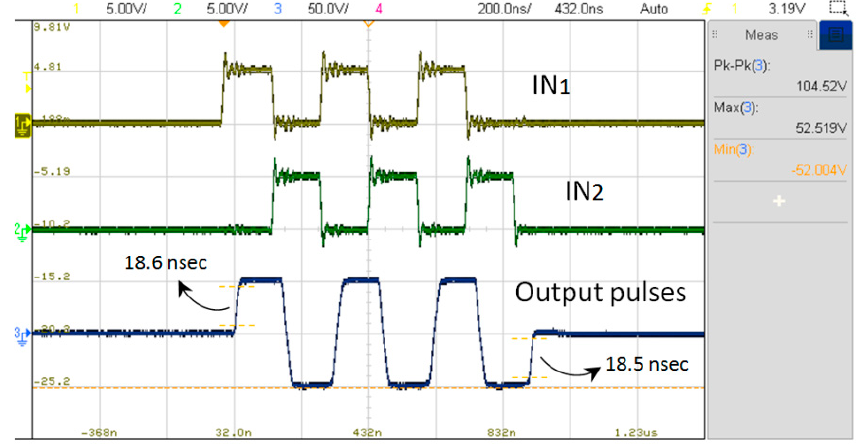
Figure 19. Measured input signals and output pulses of the designed driver under a 1-K ohm resistance in parallel with a 220-pF capacitance load.